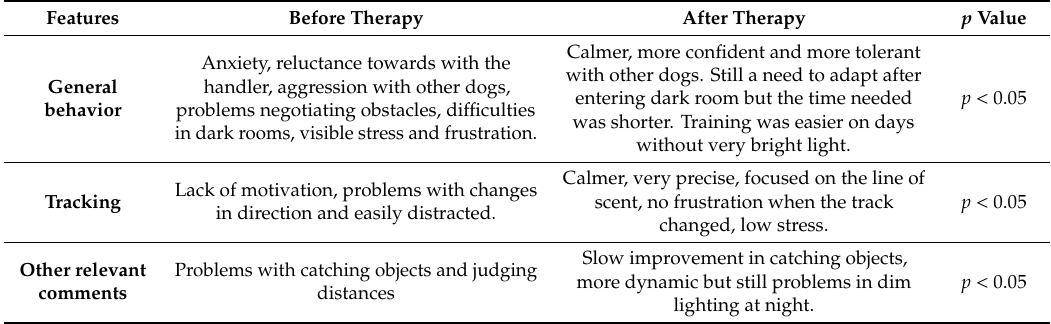
Table 2. The behavioral features of animals before and after therapy with hASC-MVs.